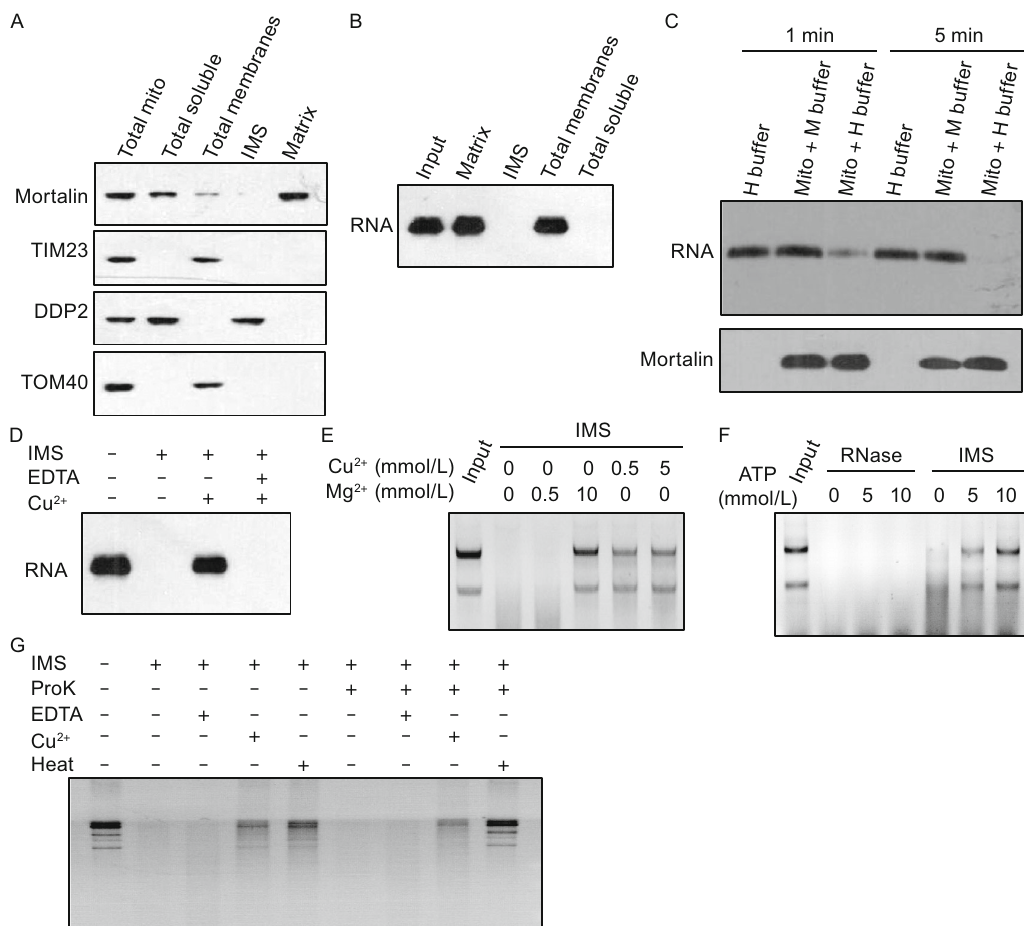
Figure 2. Characterization of a ribonuclease activity in the mitochondrial IMS. (A) Immunoblots of total mitochondria and fractions. Mitochondria were separated into four fractions: total soluble (including IMS and Matrix), total membrane, IMS and matrix. Immunoblotting was performed using antibodies for Mortalin (Matrix), TIM23 (Inner membrane), DDP2 (IMS), and TOM40 (Outer membrane). (B) Four mitochondrial fractions were examined for ribonuclease activity using biotinylated UCP2 mRNA as a substrate. (C) No ribonuclease activity localizes at the outer surface of mitochondrial outer membrane. Isolated mitochondria were resuspended in mitoprep buffer (M buffer) or hypotonic buffer (H buffer) that ruptures the mitochondrial outer membrane. Biotinylated UCP2 RNA was added to the mixture and incubated at 37°C for 1 min or 5 min before the reaction was terminated. (D) IMS ribonuclease activity was tested for its sensitivity to EDTA (2 mmol/L) and Cu 2+ (0.5 mmol/L) using biotinylated UCP2 mRNA as a substrate. (E) IMS ribonuclease activity was tested for its sensitivity to different concentrations of Cu 2+ (0.5 mmol/L and 5 mmol/L), and Mg 2+ (0.5 mmol/L and 10 mmol/L) using RNAs puri fi ed from isolated mitochondria as substrates. (F) IMS ribonuclease activity and RNaseI were tested for sensitivity to different concentrations of ATP (0 mmol/L, 5 mmol/L, and 10 mmol/L). (G) IMS ribonuclease activity was tested for sensitivity to Proteinase K (ProK), EDTA (2 mmol/L), Cu 2+ (0.5 mmol/L), and heat (90°C 10